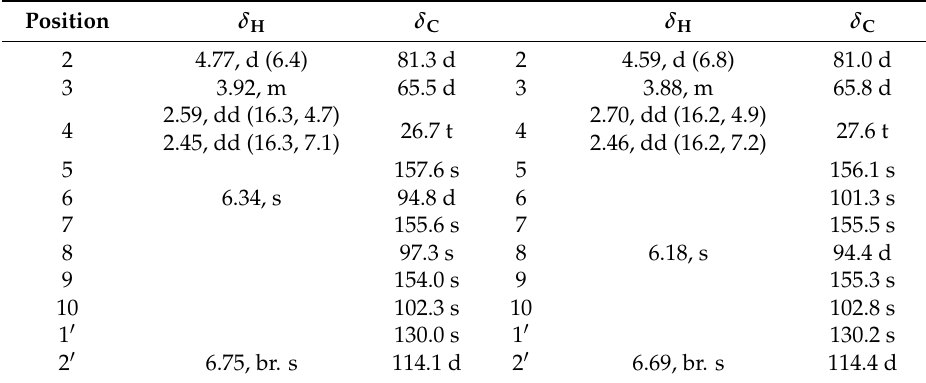
Table 1. 1 H- (600 MHz) and 13 C-NMR (150 MHz) data of 1 and 2 in DMSO- d 6 ( δ in ppm, J in